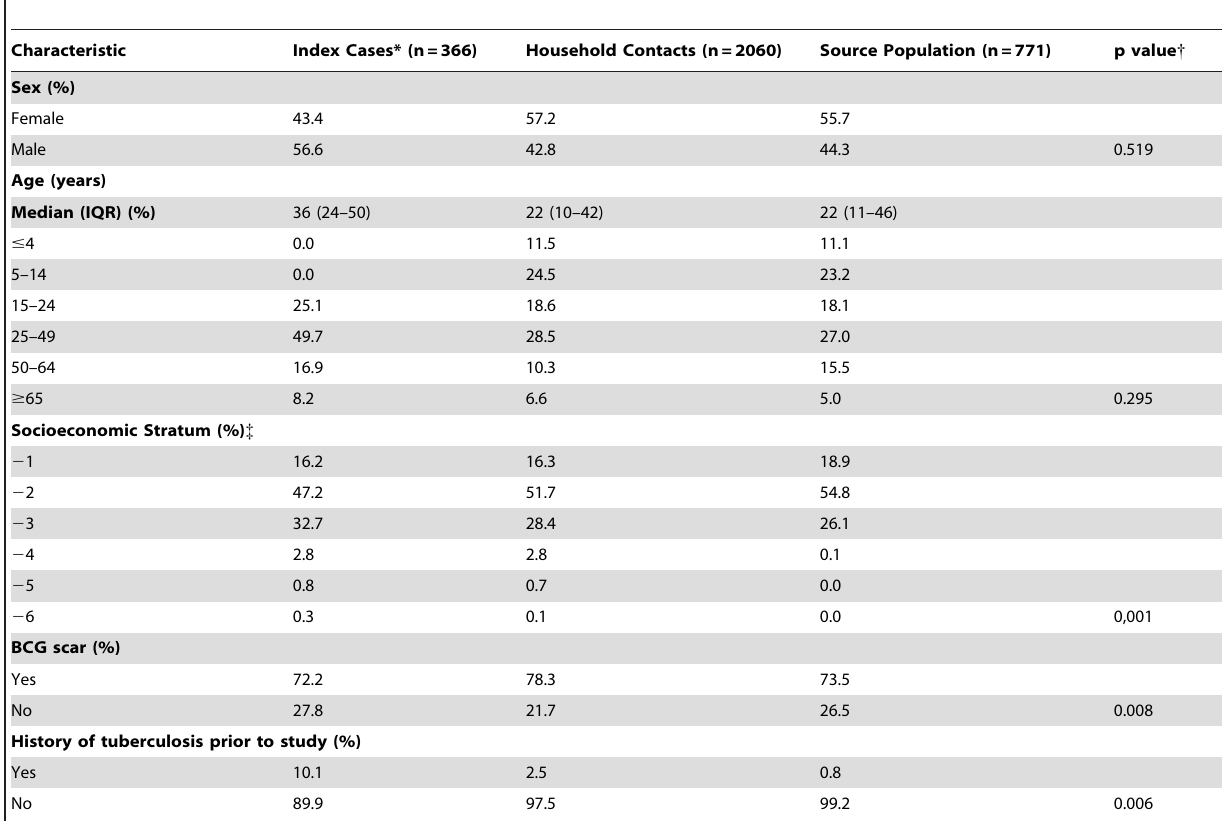
Table 1. Characteristics of household contacts (HHCs) of pulmonary tuberculosis cases and individuals from their source population